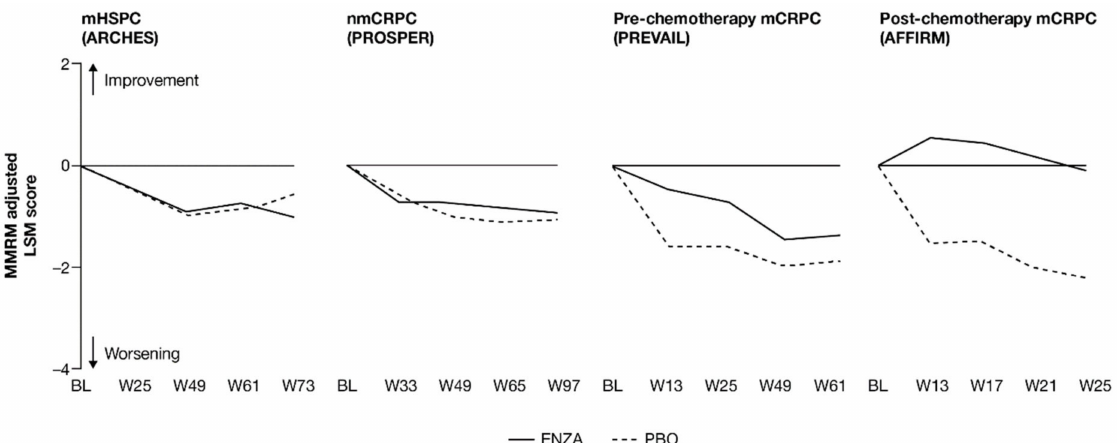
Figure 1. Adjusted change from baseline in PCS − Pain FACT-P subscale score. ENZA indicated by solid line, and control group indicated by dashed line. Abbreviations: BL: Baseline; ENZA: Enzalutamide; LSM: Least squares mean; mCRPC: Metastatic castration-resistant prostate cancer; mHSPC: Metastatic hormone-sensitive prostate cancer; MMRM: Mixed- model repeated measure; nmCRPC: Non-metastatic castration-resistant prostate cancer; PBO: Placebo; PCS: Prostate Cancer Subscale of the FACT-P; W: